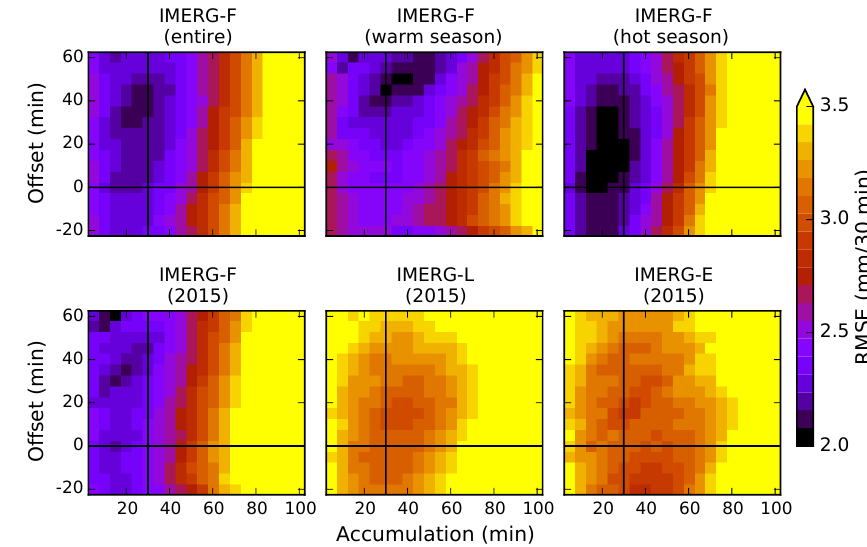
Figure 9. Contour plots of RMSE (mm30min − 1 ) between IMERG estimates and WEGN data as a function of WEGN gauge rainfall accumulation time and time offset (which means the time from which the WEGN gauge rainfall accumulation is started relative to the IMERG data start